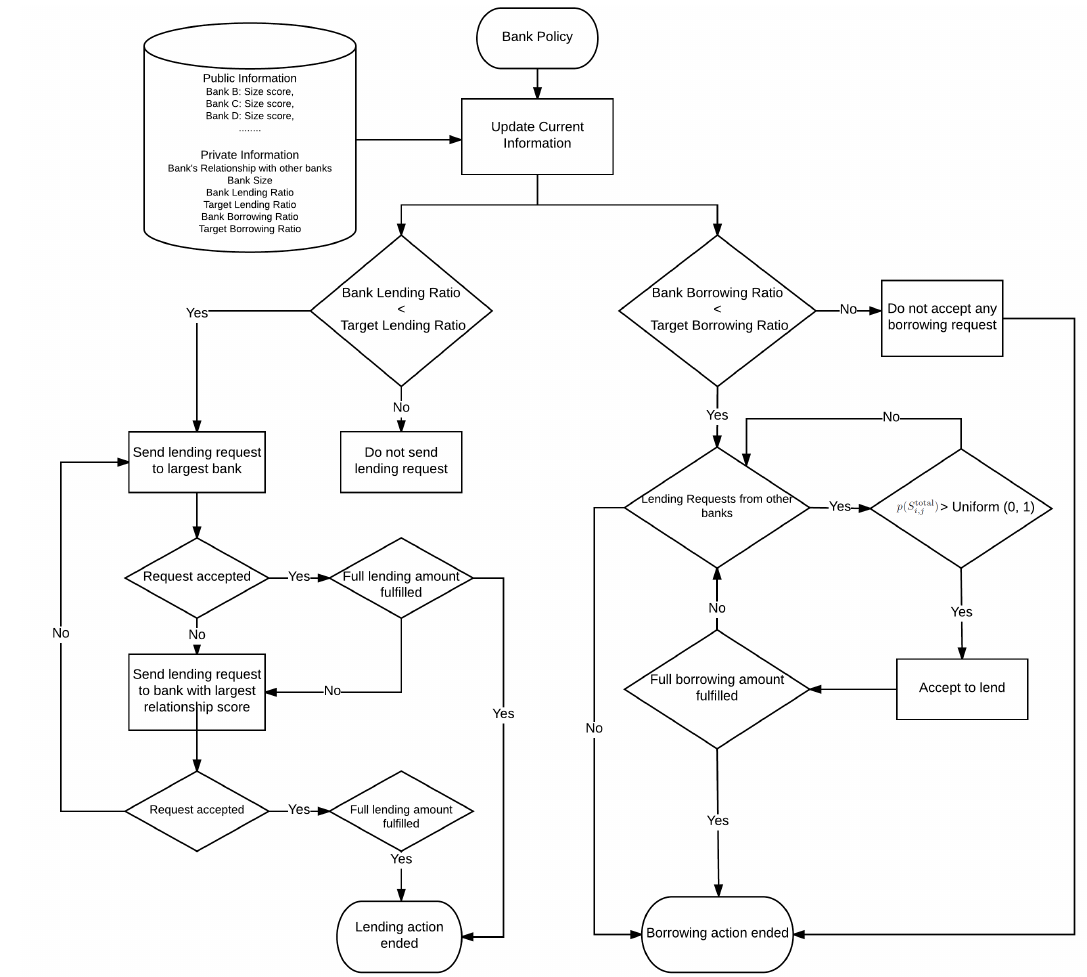
Figure 2. Bank lending and borrowing policy